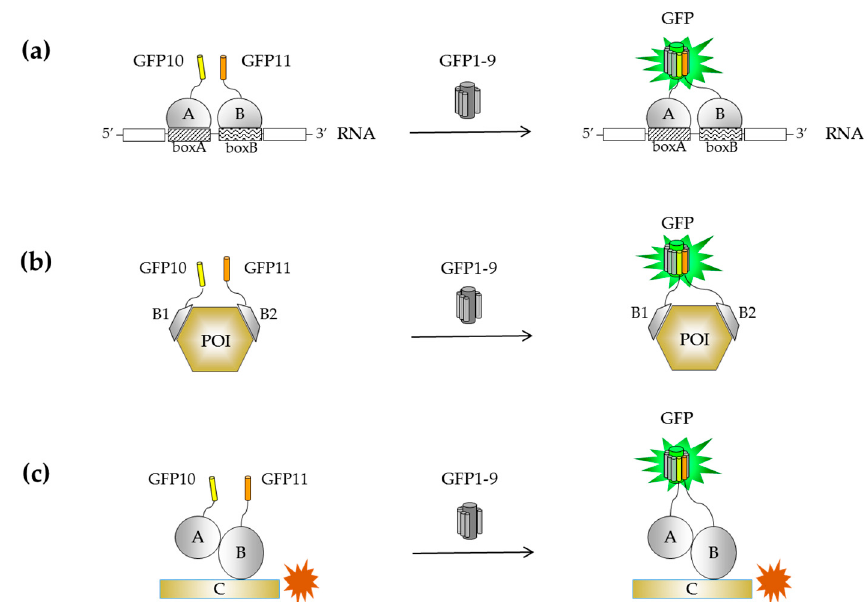
Figure 5. Tripartite split-GFP as a proximity assay tool to monitor indirect associations. ( a ) Two proteins (A and B) that bind RNA at specific target sites (boxA, boxB) are fused to GFP10 and GFP11. RNA sequences were designed to contain box A and box B in tandem (box AB), connected by a five-nucleotide linker. Binding of proteins to their target sequence forms a complex that is detected upon addition of GFP1–9. ( b ) Two affinity binders (B1 and B2) of a protein of interest (POI) are fused with GFP10 and GFP11. GFP reconstitution allows quantification of binding efficiency of B1 and B2 to their target. ( c ) The trimeric complex A-B-C is detected by co-localization of the complex formed by A/B and GFP, and the third binding partner C fused to a red fluorescent protein marker.